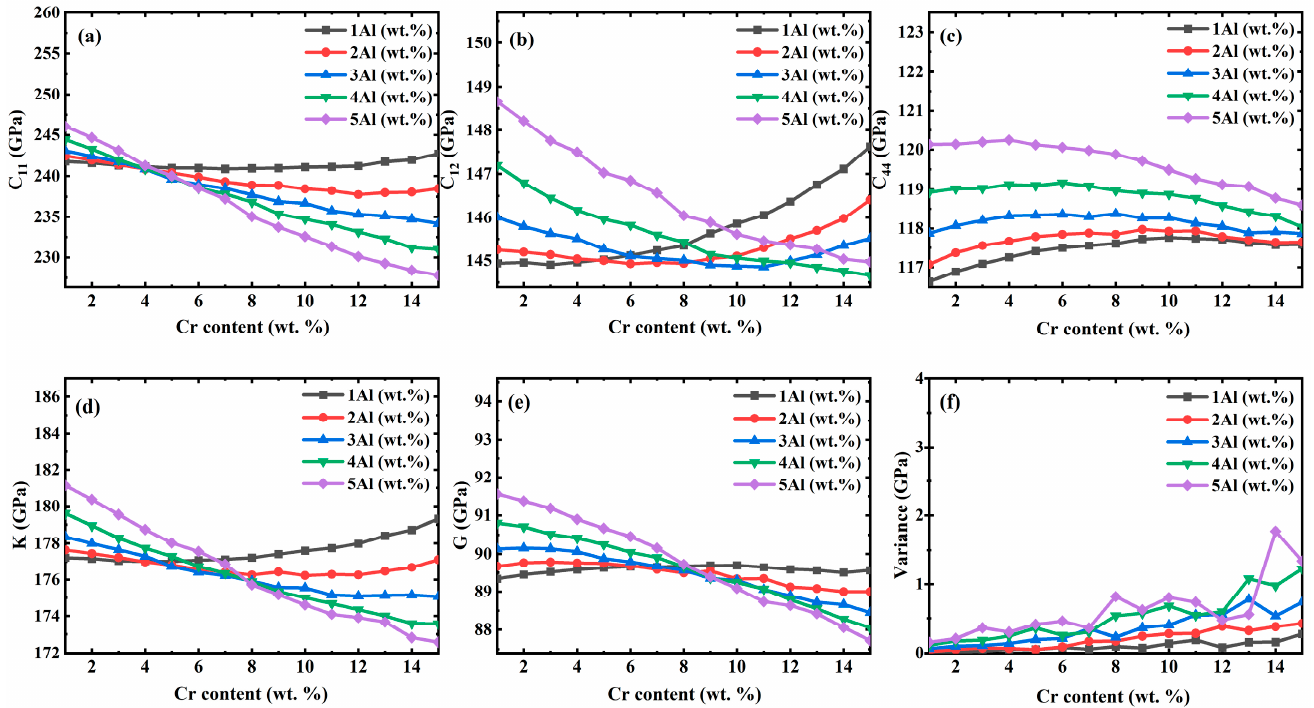
Figure 1. ( a – e ) Dependence of elastic constants, C 11 , C 12 , C 44 , bulk modulus and shear modulus on Cr and Al concentrations at 0 K. ( f ) Example of statistical uncertainties for these elastic constants based on 50 simulations.